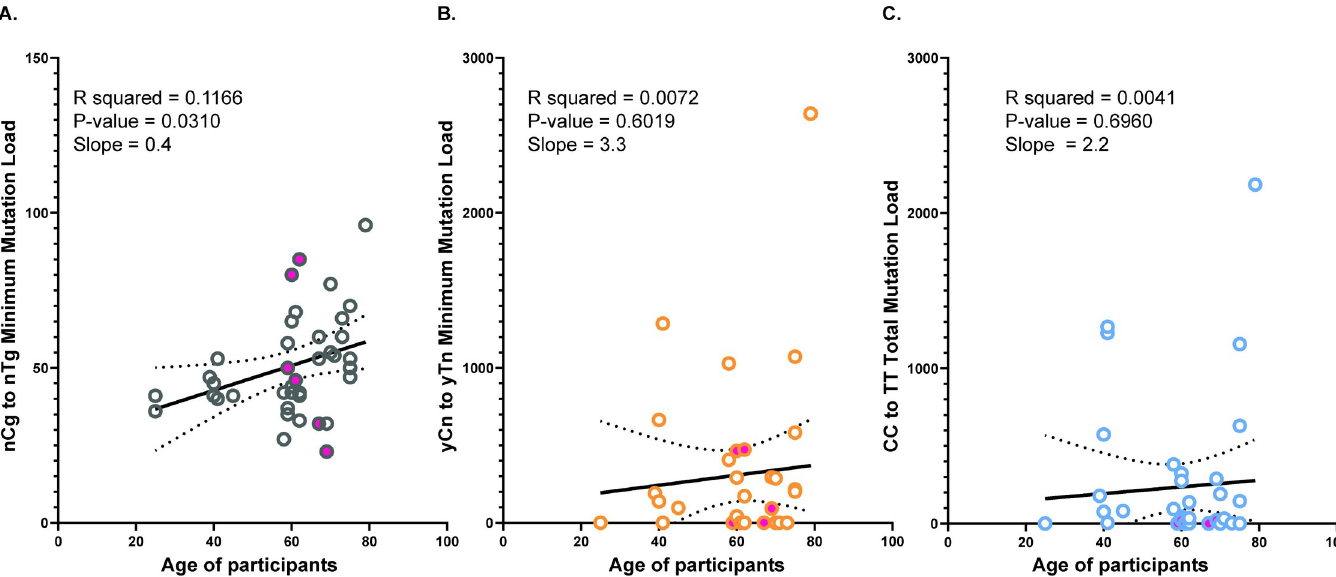
Fig 2. Analysis of the motif-specific mutation signatures in the genomes of skin cells. The minimum mutation load for the (A) nCg ➔ nTg mutation signature, (B) yCn ➔ yTn mutation signature and (C) the total mutation load for the CC ➔ TT dinucleotide changes are plotted against the ages of the participants. The solid pink circles denote the mutation load in melanocytes. The black solid line is the linear regression, and the dotted curves are the 95% confidence intervals for each dataset. The source data for this figure is S4 Table.